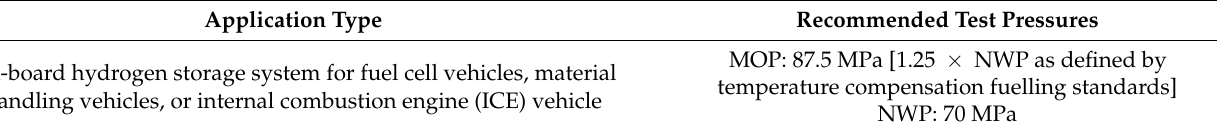
Table 8. Reference test pressures for selected applications